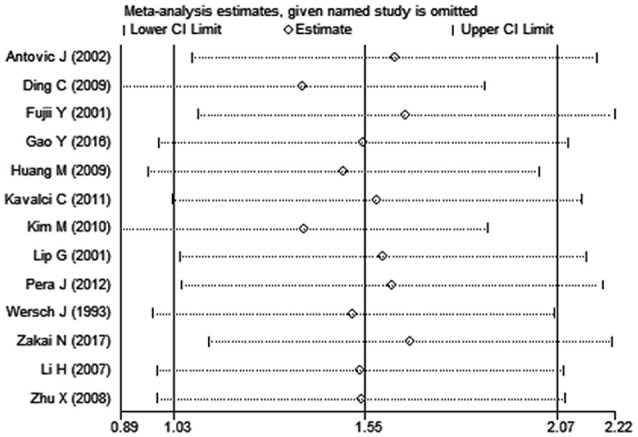
The plot in the sensitivity analysis of present meta-analysis (given named study was omitted).